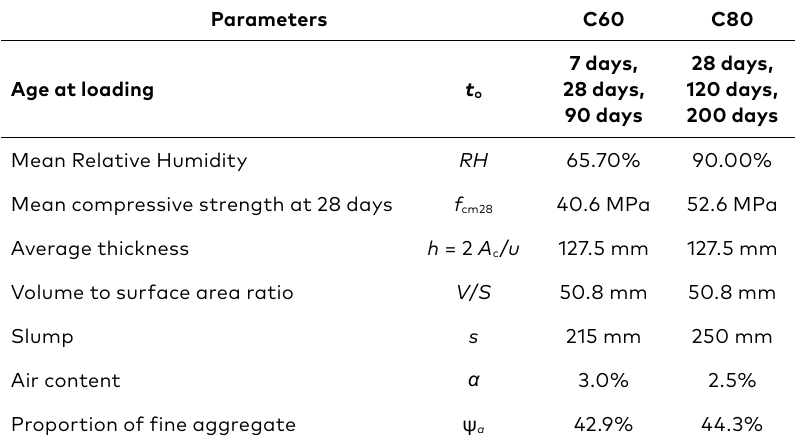
Table 4. Parameters used for prediction